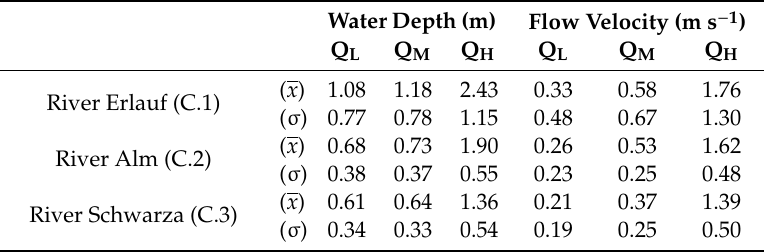
Table 5. Summary of mean values ( x ) and related standard deviations ( σ ) of water depths (m) and flow velocities (m s − 1